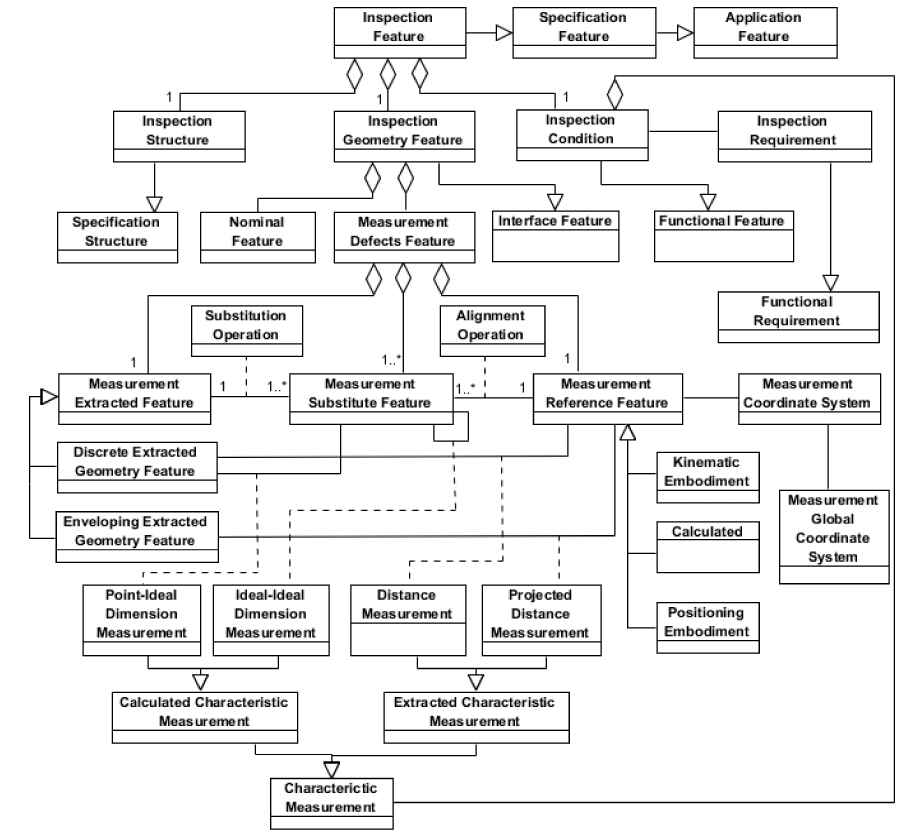
Figure 8. Inspection Feature (InspF)